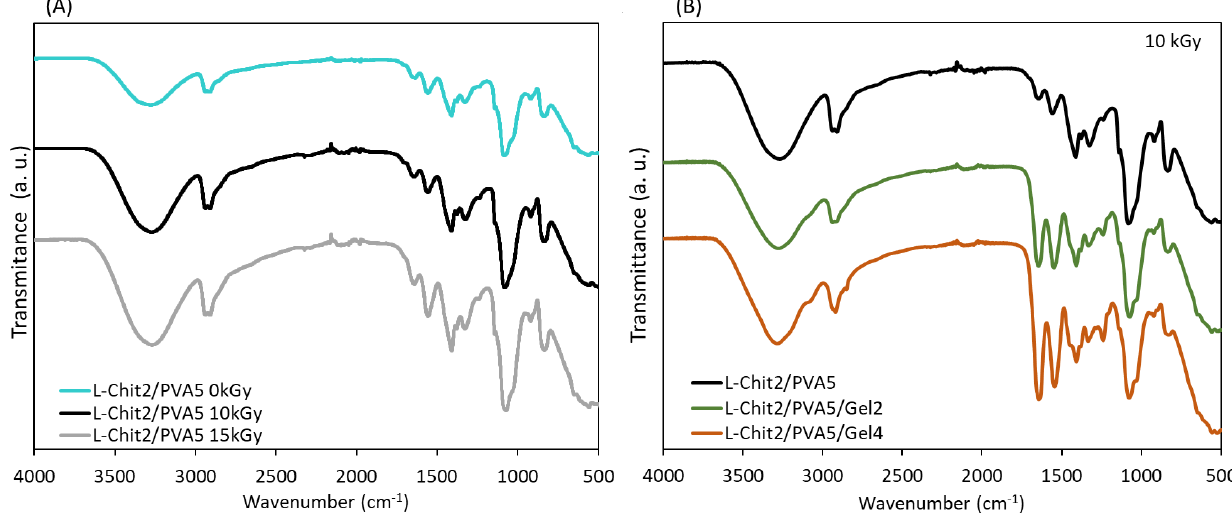
Figure 2. FTIR spectra of low Mw chitosan/PVA membranes: ( A ) non-irradiated and irradiated at 10 and 15 kGy; ( B ) At 10 kGy and different content of gelatin.